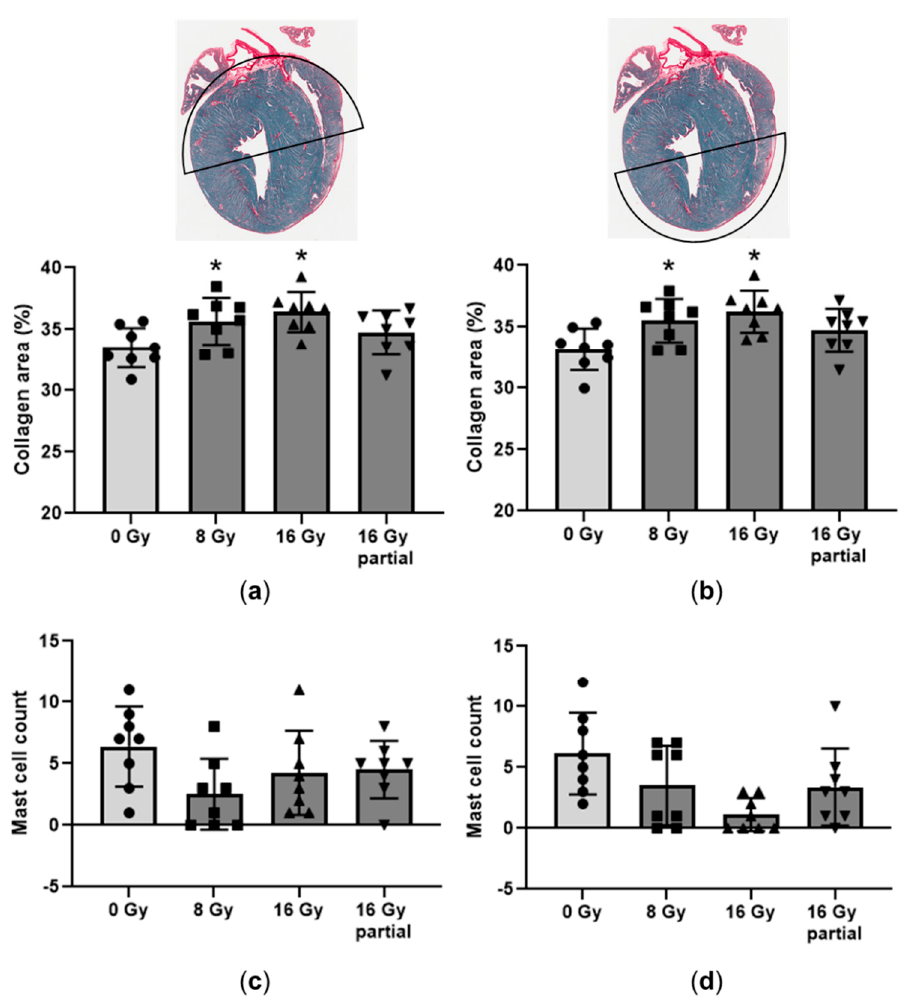
Figure 1. Cardiac histology 6 months after irradiation . Cardiac tissue area occupied by collagens was assessed ( a ) in the top half of the heart and ( b ) in the bottom half of the heart. Cardiac mast cell counts were determined ( c ) in the top of the heart and ( d ) in the bottom of the heart. Male and female data are combined, n = 8 animals per group. * p < 0.05 compared to 0 Gy.